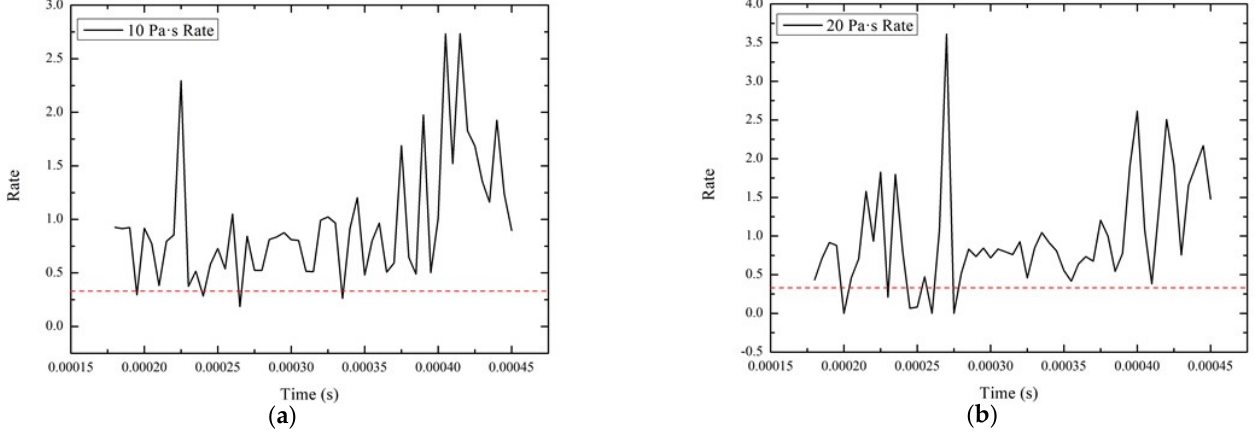
Figure 10. Force ratio of the tangential force to the normal force under different viscosities ( a ) 10 Pa·s viscosity, ( b ) 20 Pa·s viscosity, ( c ) 30 Pa·s viscosity, ( d ) 40 Pa·s viscosity. 4.3. Speed Analysis The clustering effect of STF can not only bring about the high-shear low-pressure grinding effect, but can also absorb the impact kinetic energy of the micro-peaks and re- duce the impact speed of the micro-convex peak. The speed changes at different viscosi- ties are shown in Figure 11. Due to the clustering effect of STF, the speed of the micro- convex peak decreases significantly, which indicates that the kinetic energy absorption effect of STF is more significant. The speed changes rate between the viscosities of 10 Pa·s